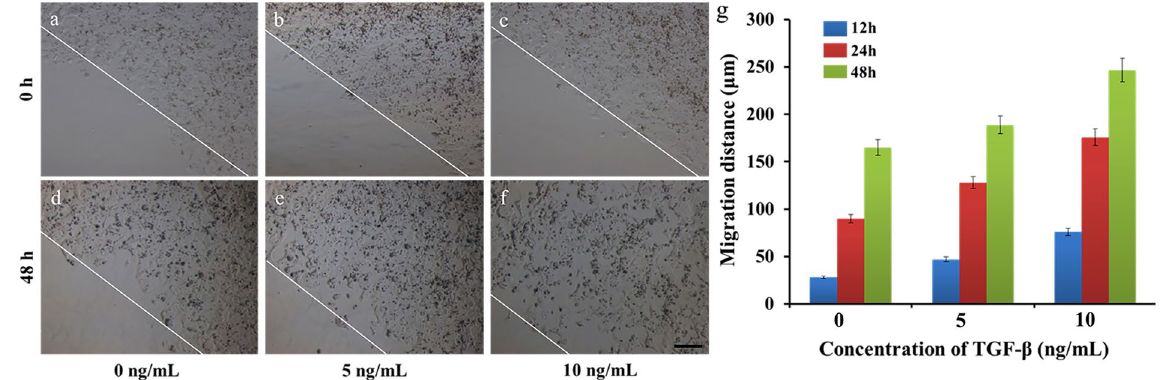
Figure 6. Representative images of MCF-7 cell migration under treatment with different concentrations of TGF- β . ( a and d ) Control. ( b and e ) 5 ng/mL TGF- β . ( c and f ) 10 ng/mL TGF- β . ( g ) Statistical graph for each concentration of TGF- β at different times. The error bars represent the SD from three different experiments on three differebt devices (n = 3). P < 0.05. The images were taken at 0, 12, 24, and 48 h. The lines indicate the initial leading edges at 0 h and the migrated edge after 48 h of migration. The scale bar in the picture represents 100 μ